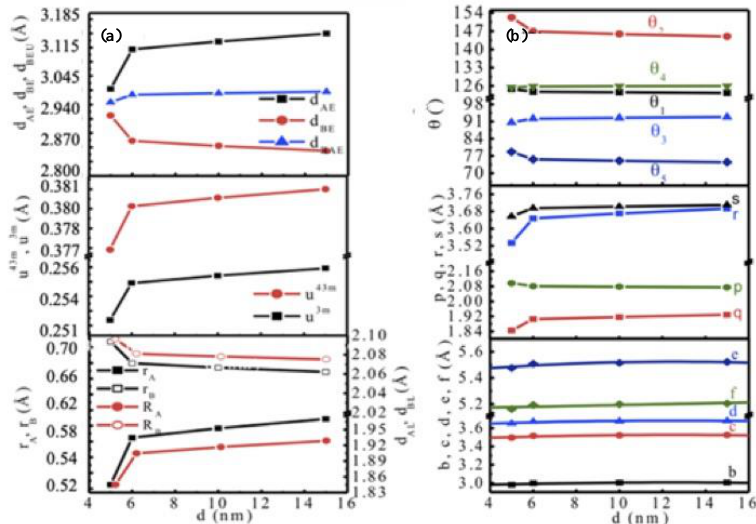
Figure 2. XRD studies of as-dried MnFe 2 O 4 nanoparticles synthesized at different pH. ( a ) nanoparticle size dependence of ionic radii on tetrahedral and octahedral sites (r A and r B ) (left axis) and bond length (d AL and d BL ) (right axis), oxygen parameters (u) and shared tetrahedral edge (d AE ), shared octahedral edge (d BE ), unshared octahedral edge (d BEU ), ( b ) nanoparticle size dependence of interionic distances between cations (Me-Me) (b, c, d, e, f), between cations and anions ( p , q , r , s ) and bond angles ( θ 1 , θ 2 , θ 3 , θ 4 , θ 5 ).